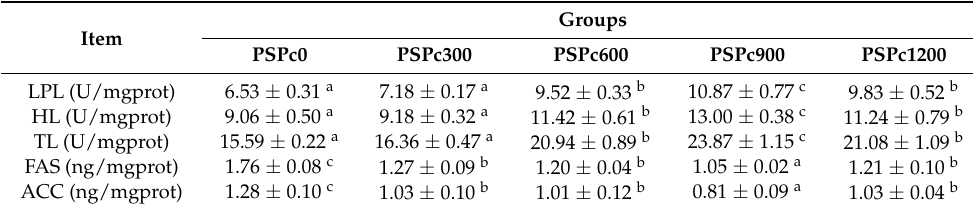
Table 4. The activity or level of lipid metabolic enzymes in the liver of juvenile American eels in the different PSPc